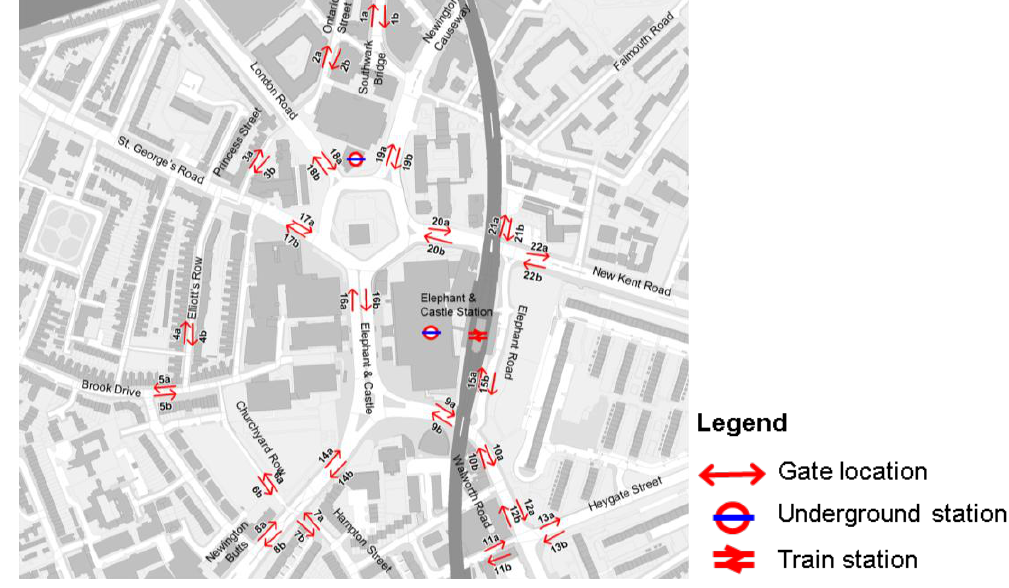
Figure 7. This figure highlights the gate locations for the cyclist movement survey.